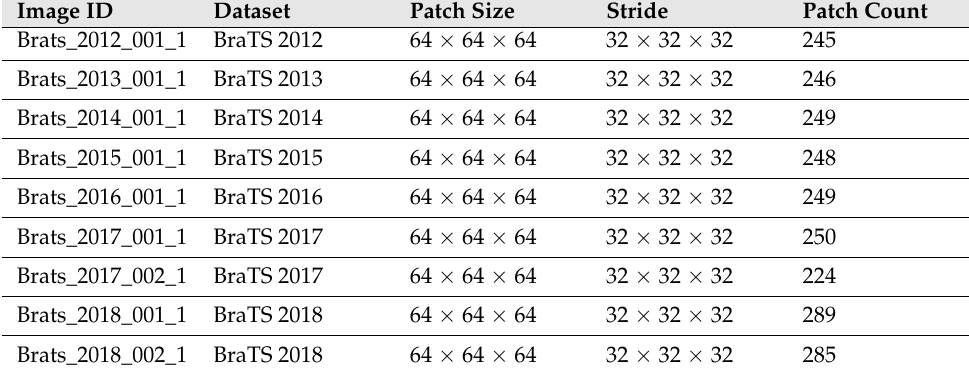
Table 5. Datasets with image ID, patch size, stride, and patch